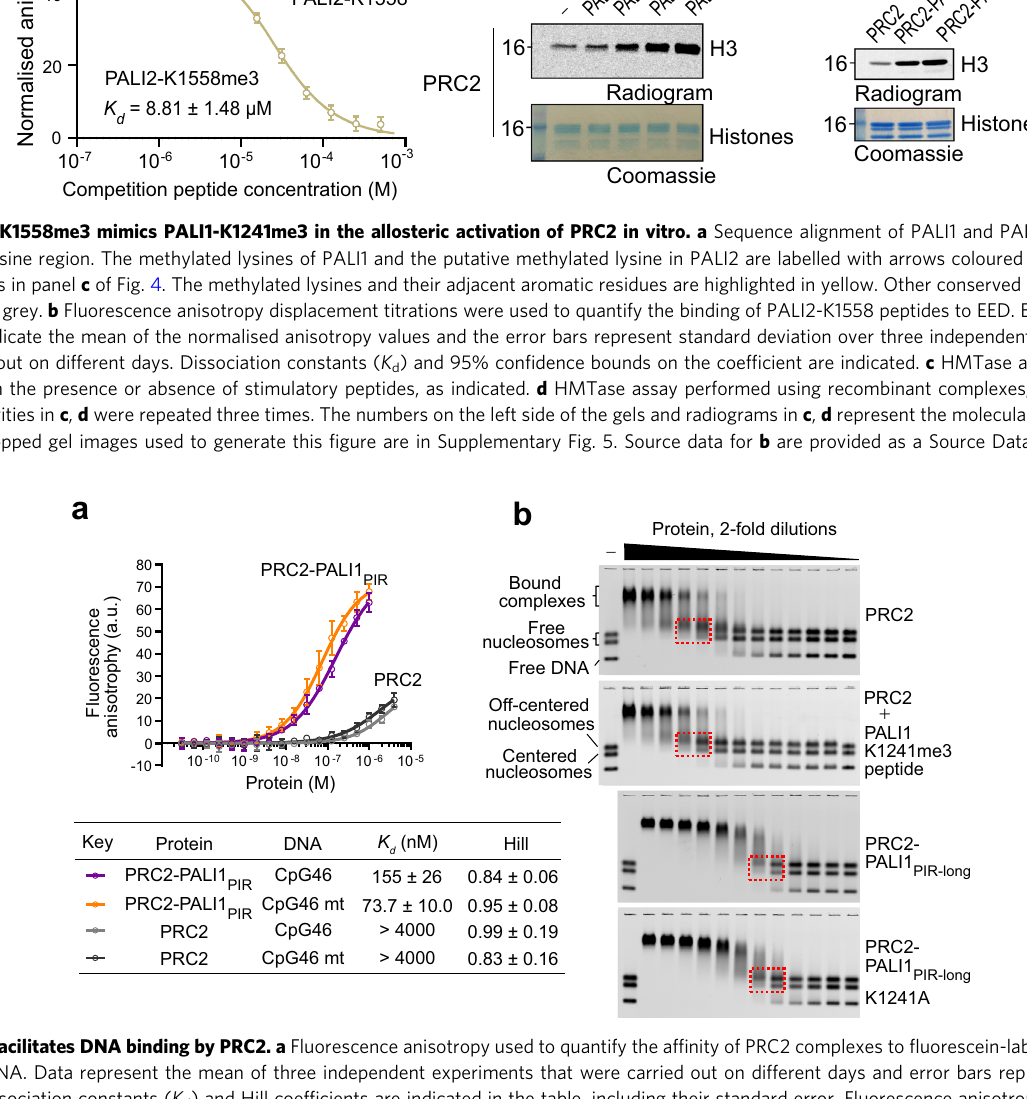
formed electrophoretic mobility shift assays (EMSA) using a fl uorescently labelled mononucleosome probe that was recon- stituted using a 182-bp-long DNA. The probe was reconstituted to allow for the simultaneous detection of the interactions between PRC2 and nucleosomes, at either the centred or the off- centred positions 38 , or between PRC2 and the free DNA (Fig. 6b).